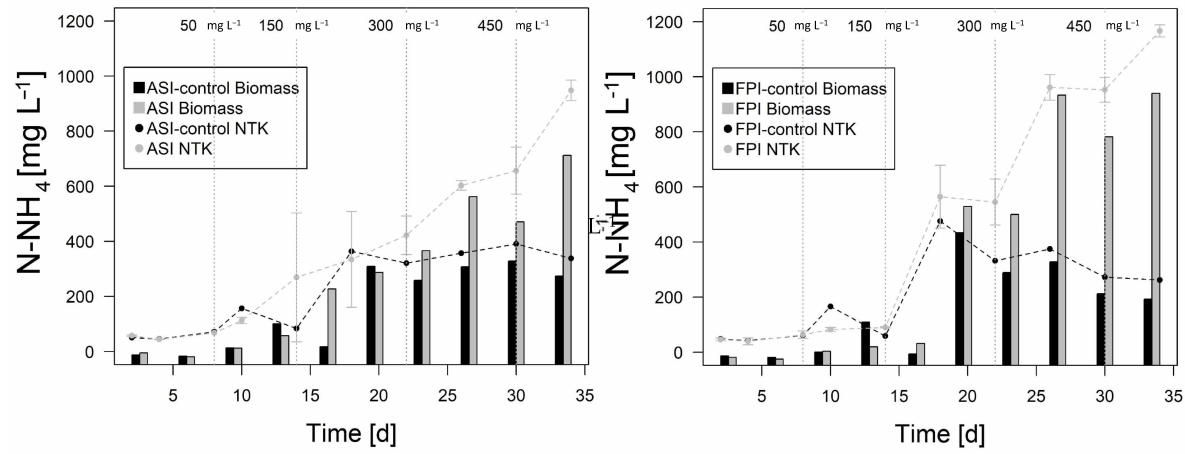
Figure 3. Total N-NH 4 (dot plot) and Biomass (bar plot) content found in the bioreactors ( a ) ASI and ( b ) FPI. ASI-control: Activated Sludge Control. FPI-control: Facultative Pond